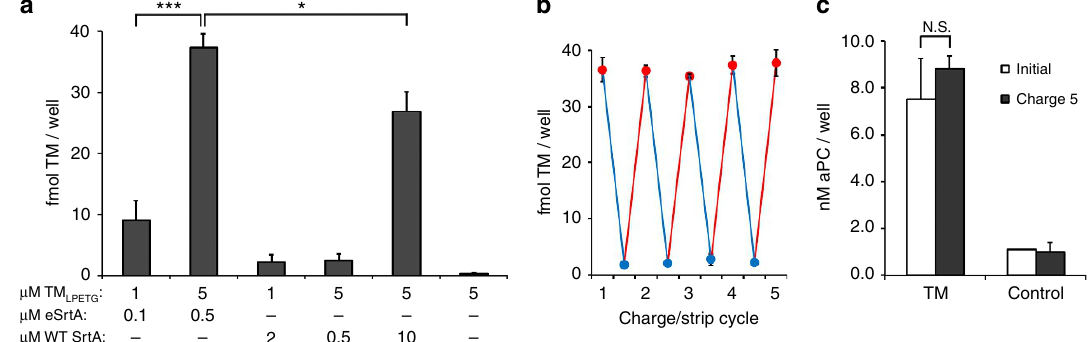
Figure 3 | Repetitive surface recharging in the presence of whole blood. ( a ) Direct sortase-catalysed assembly of TM LPETG in 50% v/v heparinized whole blood (20U heparin per ml of blood) at 37 (cid:2) C for 1h without additional calcium. Evolved and WT sortases were tested at two different TM LPETG concentrations as well as TM LPETG /sortase ratios. ( b ) Sequential eSrtA-catalysed charging (red) and stripping (blue) cycles of TM LPETG performed on model pentaglycine surfaces in 50% v/v heparinized whole blood (20U heparin per ml of blood) at 37 (cid:2) C for 1h without additional calcium. ( c ) TM co-factor activity (nM aPC/well) was characterized on initial surfaces and after the fifth generation of charging. Blank wells were included as control. N.S. (not significant), * P o 0.05, *** P o 0.001 (Student’s t -test), error bars denote s.d. ( n Z